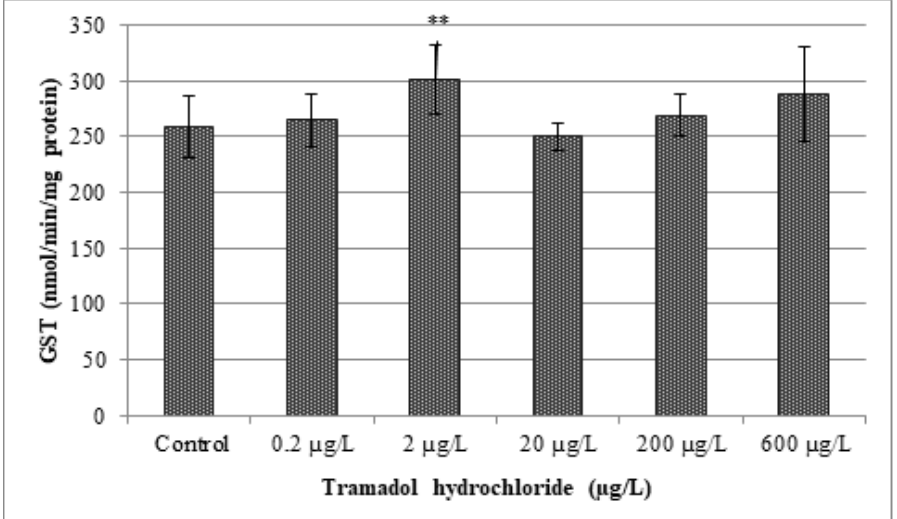
Figure 4. Analysis of glutathione reductase activity (GR). Data are expressed as mean ± standard deviation. No significant differences ( p > 0.05) were found between control and experimental groups.